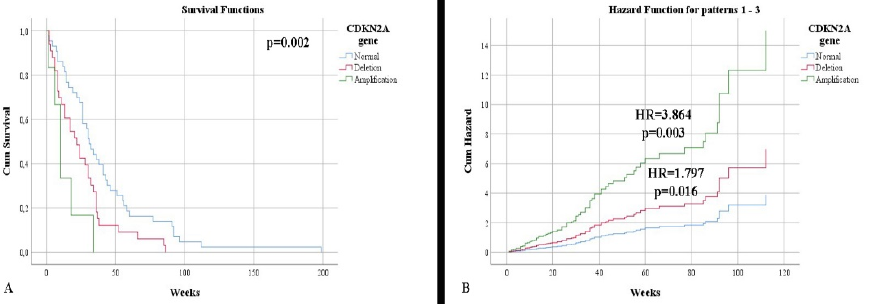
Figure 3. ( A ) Kaplan Meier survival graphic that shows a lower survival rate for patients with alterations of CDKN2A gene. ( B ) Univariate cox regression analysis that expresses the risk of death in presence of deletions and amplifications of CDKN2A